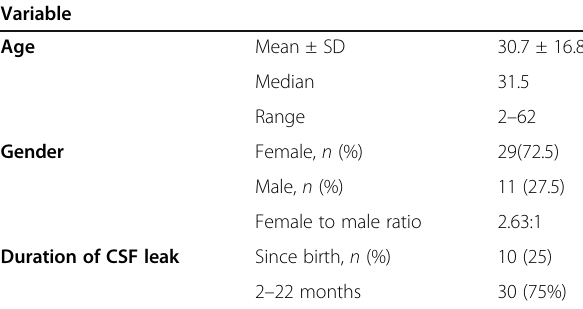
Table 1 Age and gender distribution of the studied groups Variable